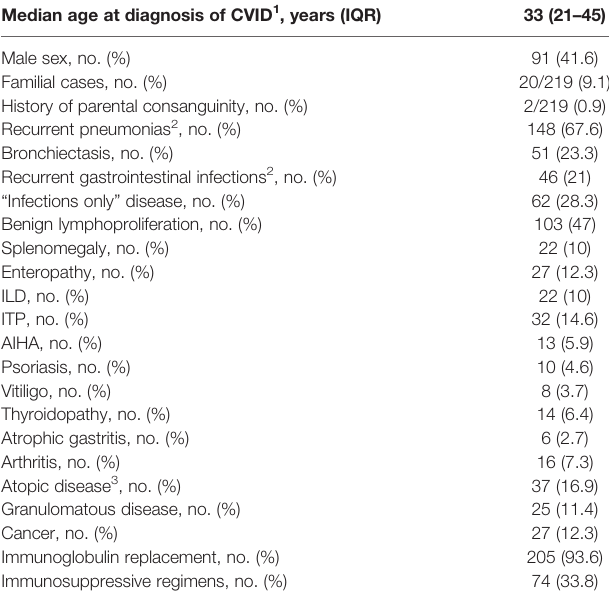
TABLE 1 | Characteristics of studied patients ( N = 219).